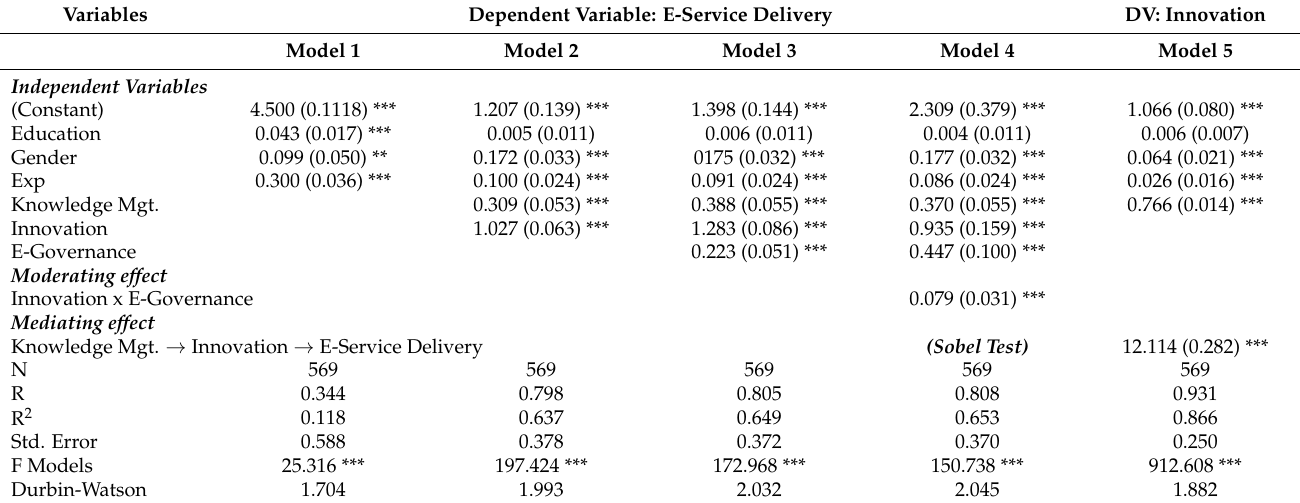
Table 4. Multiple regression analysis—the effect of AI-based KM, innovation, and e-governance on e-service delivery.